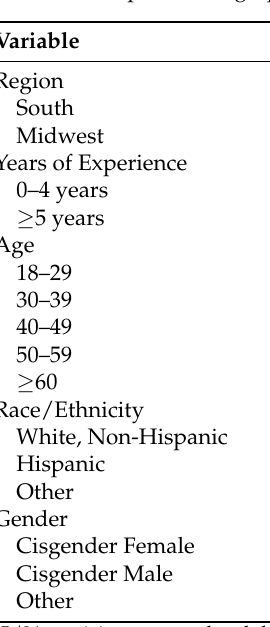
Table 1. Participant demographics ( n = 15